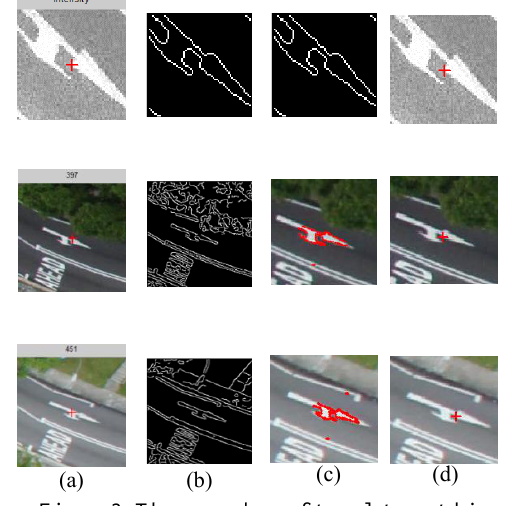
Figure 3. The procedure of template matching.